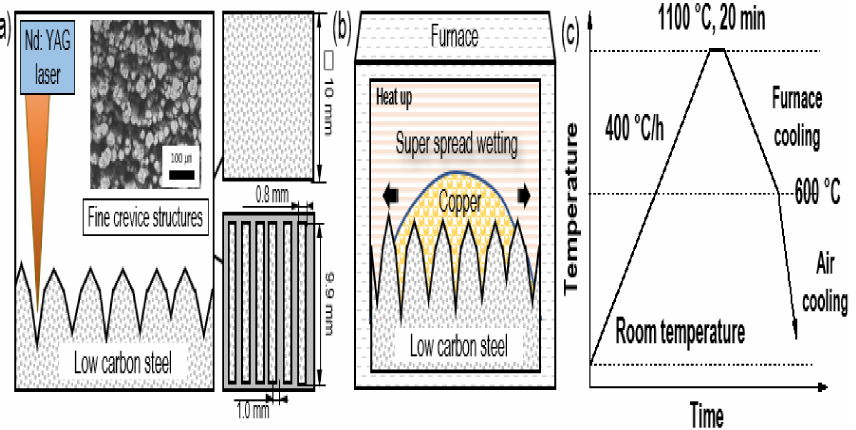
Figure 1. Schematic diagram of the different steps of fabricating procedure: ( a ) formation of fine crevice structure and pattern shape using Nd: YAG laser; ( b ) process for copper coating by super- spread wetting properties; ( c ) heat temperature profile for the coating